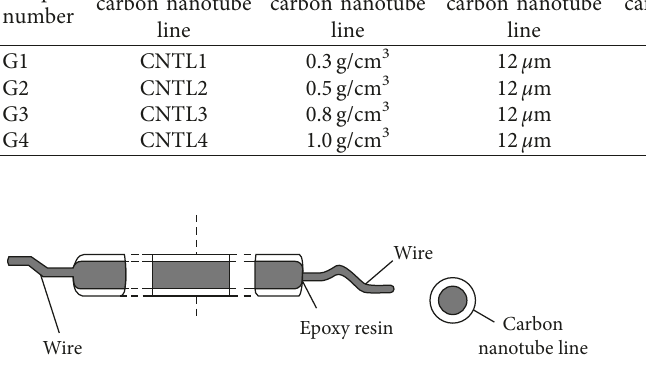
Figure 5: Interface with stitches of the carbon nanotube line.